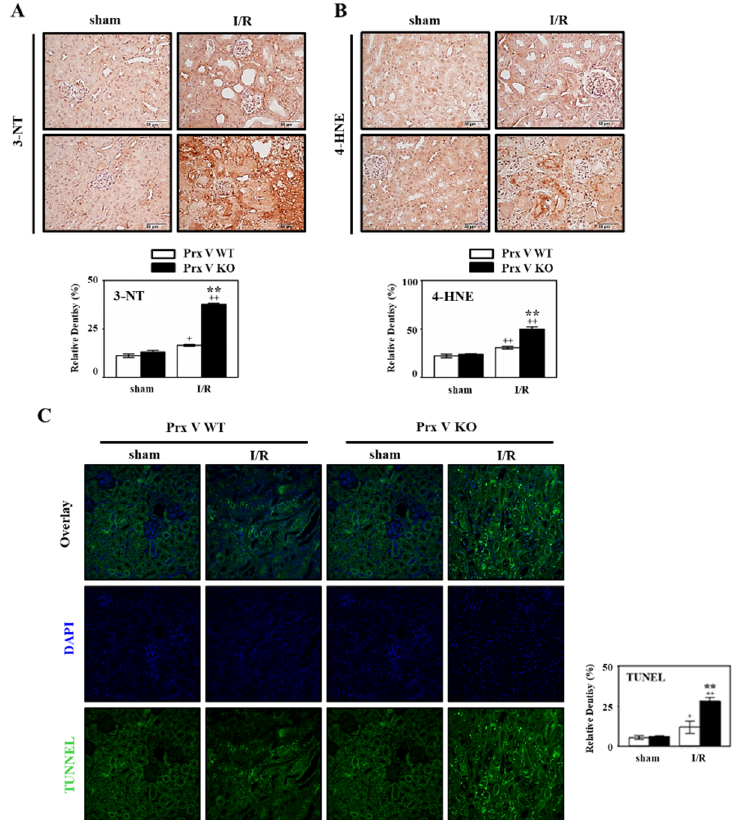
Figure 5. Effect of Prx V ablation on oxidative damage and apoptotic damage during renal I/R. ( A ) IHC with antibodies to ( A ) 3-NT and ( B ) 4-HNE as oxidation marker of tyrosine and lipid. ( C ) The kidney sections were subjected to TUNEL assay. NIS-Elements AR 3.1 software was used to quantify. Original magnification, 400×. Data are shown as means ± SE. n = 5–6, ** p < 0.01 vs. WT, + p < 0.05 vs. sham, ++ p < 0.01 vs. sham.